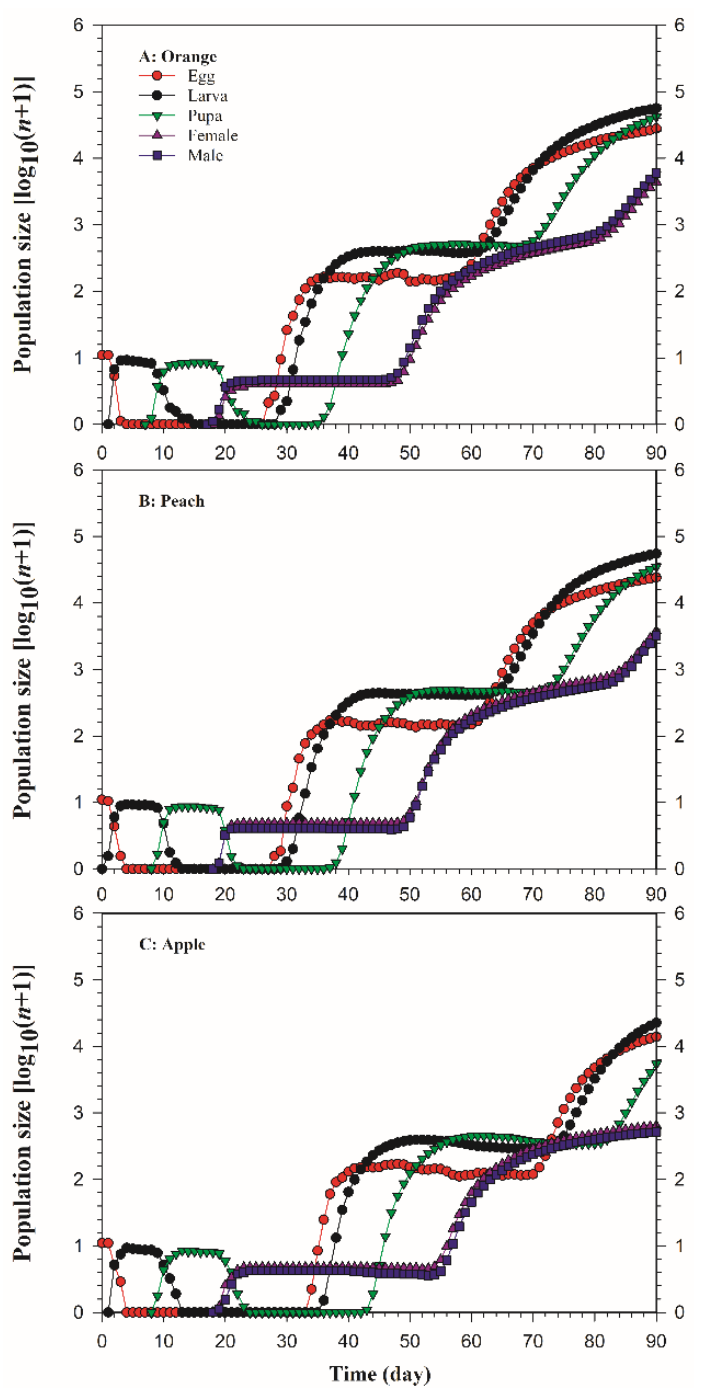
Figure 5. Population prediction of Bactrocera dorsalis on three host fruits. An initial population of 10 eggs was used in each projection: ( A ) orange; ( B ) peach; ( C ) apple.